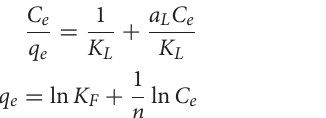
indicated the high host–guest affinity at lower concentrations.